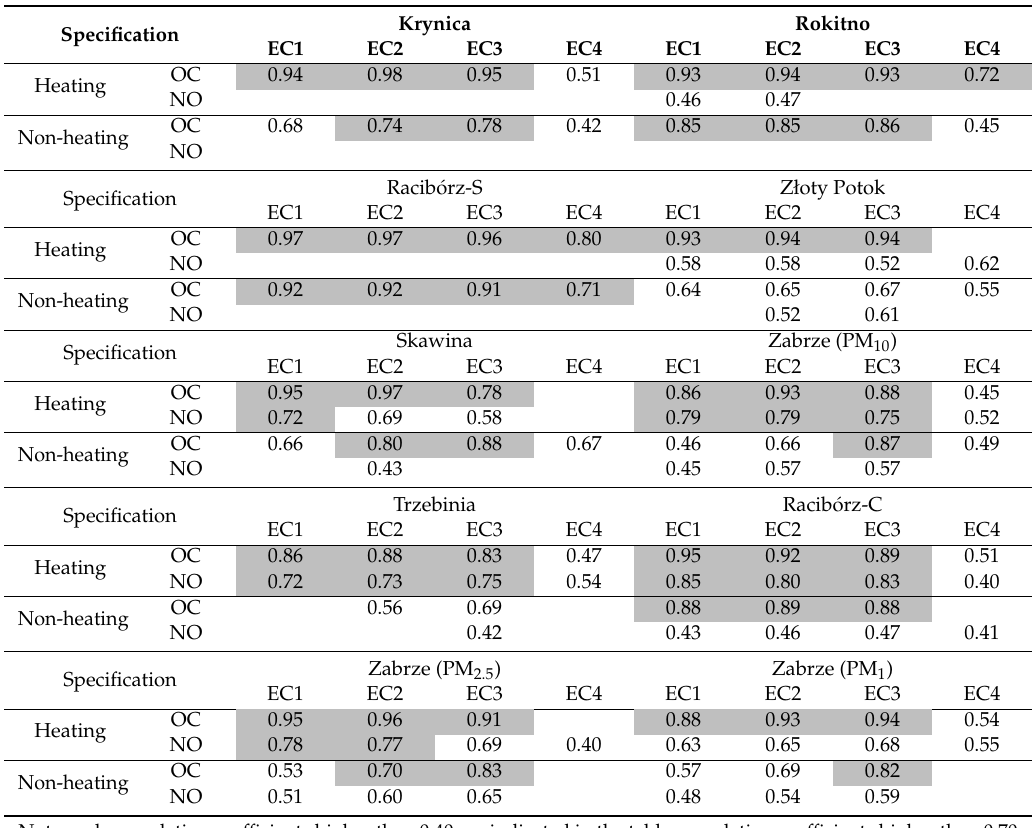
Table 6. Results of nonparametric (Spearman) correlation analysis ( α = 0.05) between concentrations of EC1-4 and PC fractions and concentrations of OC and